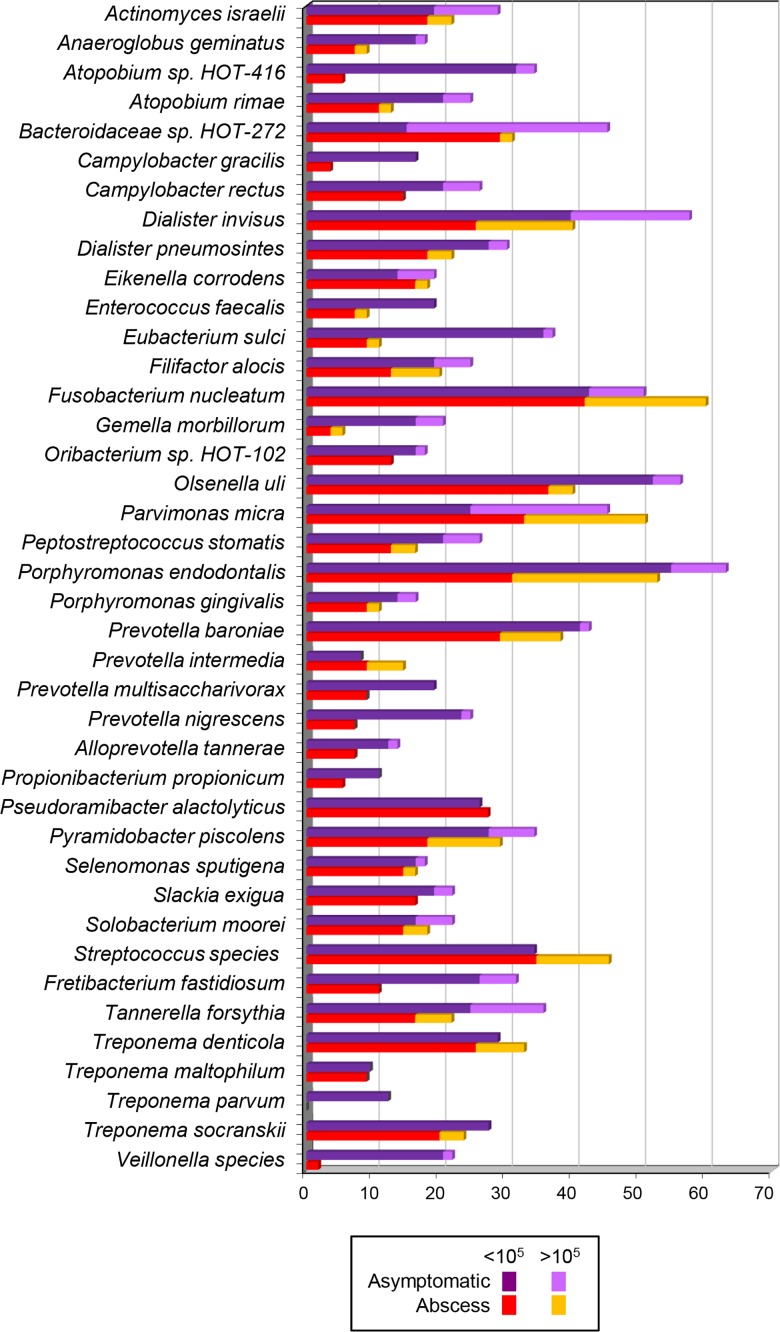
Stacked bar chart of frequency of detection and levels of bacterial taxa in samples from teeth with acute apical abscess or asymptomatic apical periodontitis.Total length of each bar stack indicates percentage of positive samples. Different colors within each bar indicate percentage of samples containing each level range (< or > 105 cells).